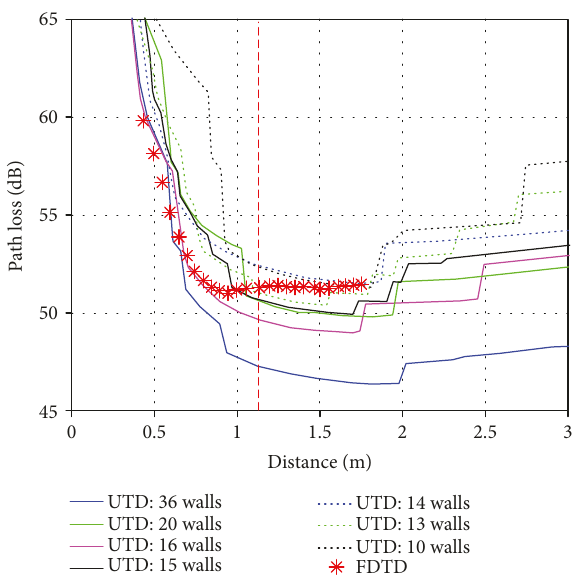
Figure 11: Path loss results obtained in simulations using XGtd (UTD method) and XFdtd (FDTD method) for body orientation 1 and for di ff erent numbers of side walls in the UTD